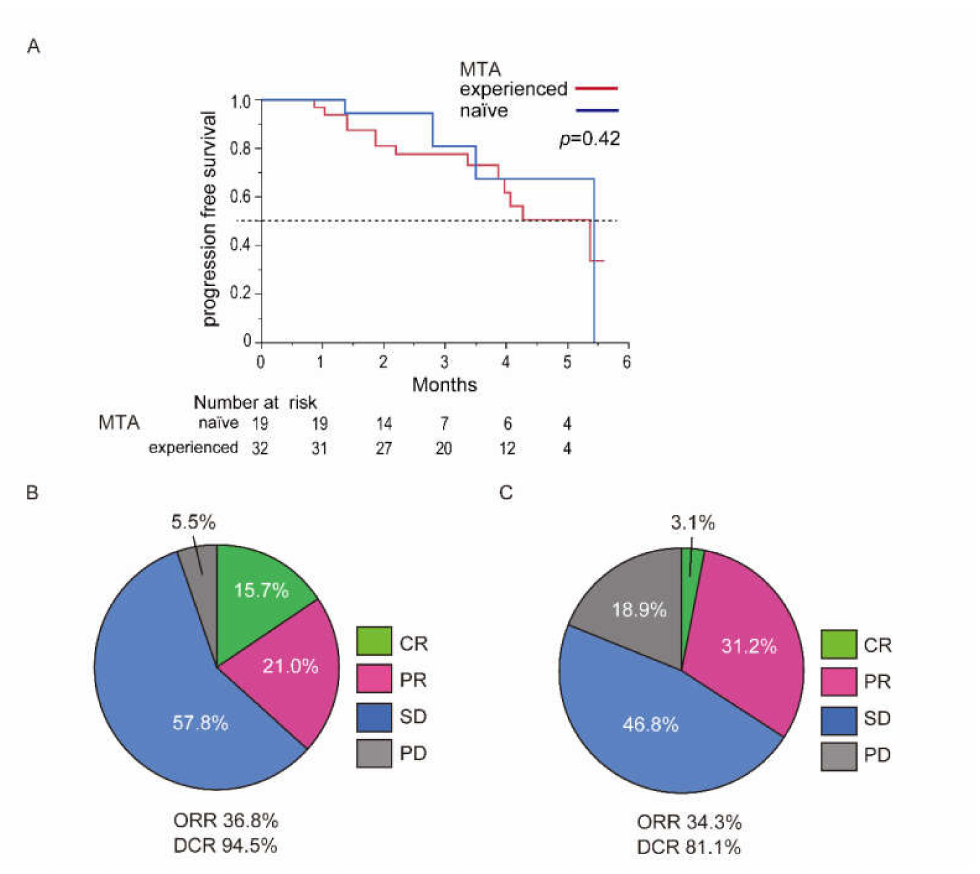
Figure 3. Difference of PFS and therapeutic response of atezolizumab plus bevacizumab between MTA-naïve and -experienced cases. ( A ) The PFS curves of the MTA-naïve and -experienced patients treated with atezolizumab plus bevacizumab. The blue line expresses the MTA-naïve patients. The red line expresses the MTA-experienced patients. ( B ) Assessment of the therapeutic response in MTA-naïve patients. Modified RECIST is used for assessment. ( C ) Assessment of the therapeutic response in the MTA-experienced patients. Modified RECIST is used for assessment. Abbreviations: PFS, progression free survival; MTA, molecular targeted